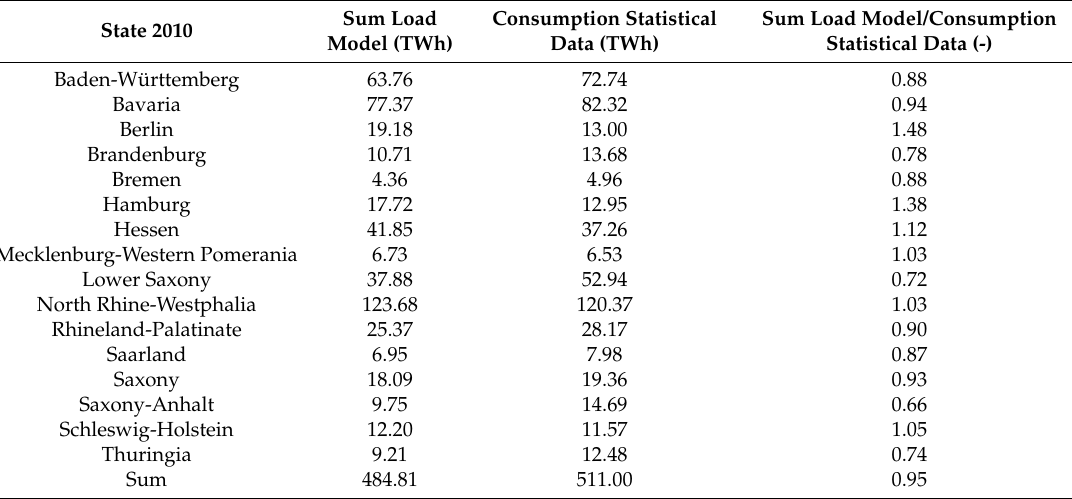
Table 3. Comparison: model vs. statistical data in 2010 [37,41–56].